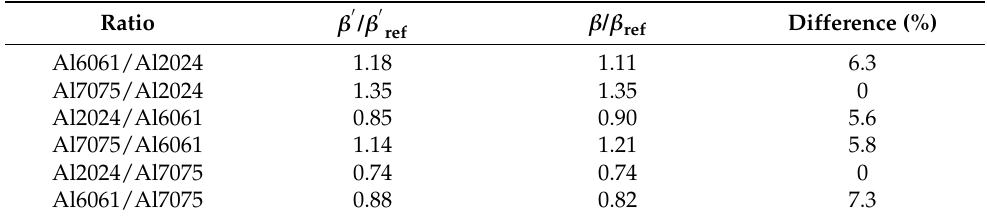
Table 5. Comparison of the relative nonlinear parameter ratio and absolute nonlinear parameter ratio.